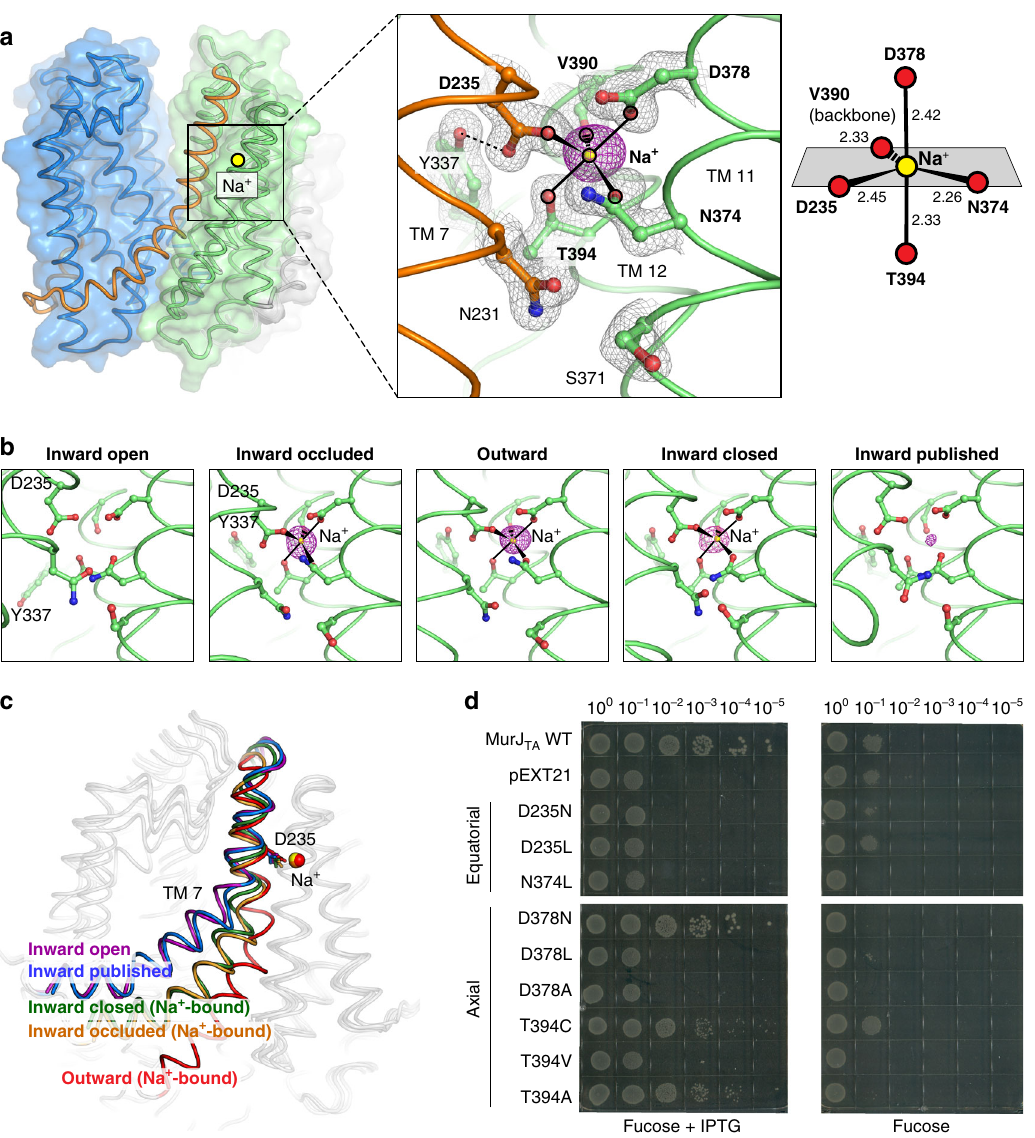
Fig. 5 The sodium binding site in MurJ TA . a Na + is bound in the C-lobe (TMs 7, 11, 12) coordinated by Asp235, Asn374, Asp378, Val390 (backbone carbonyl), and Thr394. Fo − Fc omit density for Na + is shown as magenta mesh contoured to 4.5 σ (peak height ~19 σ , 1.8 Å resolution). 2Fo − Fc omit density is shown in gray mesh. Na + is coordinated by trigonal bipyramidal geometry. b Na + was also bound in the inward-occluded and inward-closed structures. c Na + -associated rearrangement could be propagated down TM 7. d Complementation assay of MurJ TA sodium site mutants in MurJ EC - depletion strain NR1154. Cells transformed with plasmids encoding MurJ TA (wild-type or sodium site mutant) or without insert (pEXT21) were depleted of endogenous MurJ by serial dilution on agar plates containing the anti-inducer D -fucose. MurJ TA expression was induced by addition of IPTG. Data shown are representative of three biological replicates. Source data are provided as a Source Data File. Mutants D235A and N374A were previously determined to neither express nor complement